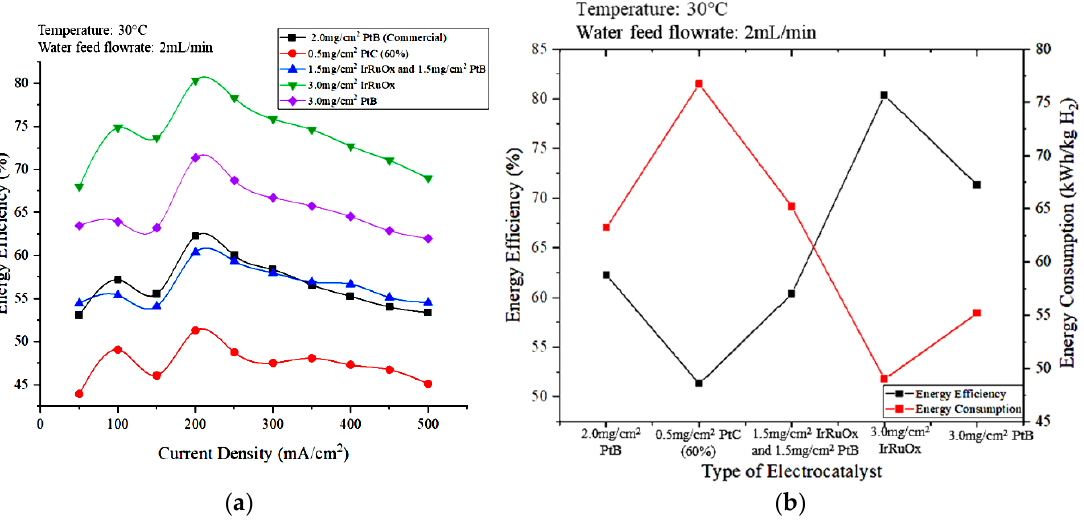
Figure 12. Effects of electrode types on ( a ) the energy efficiency versus current density and ( b ) energy efficiency and energy consumption at 200 mA/cm 2.